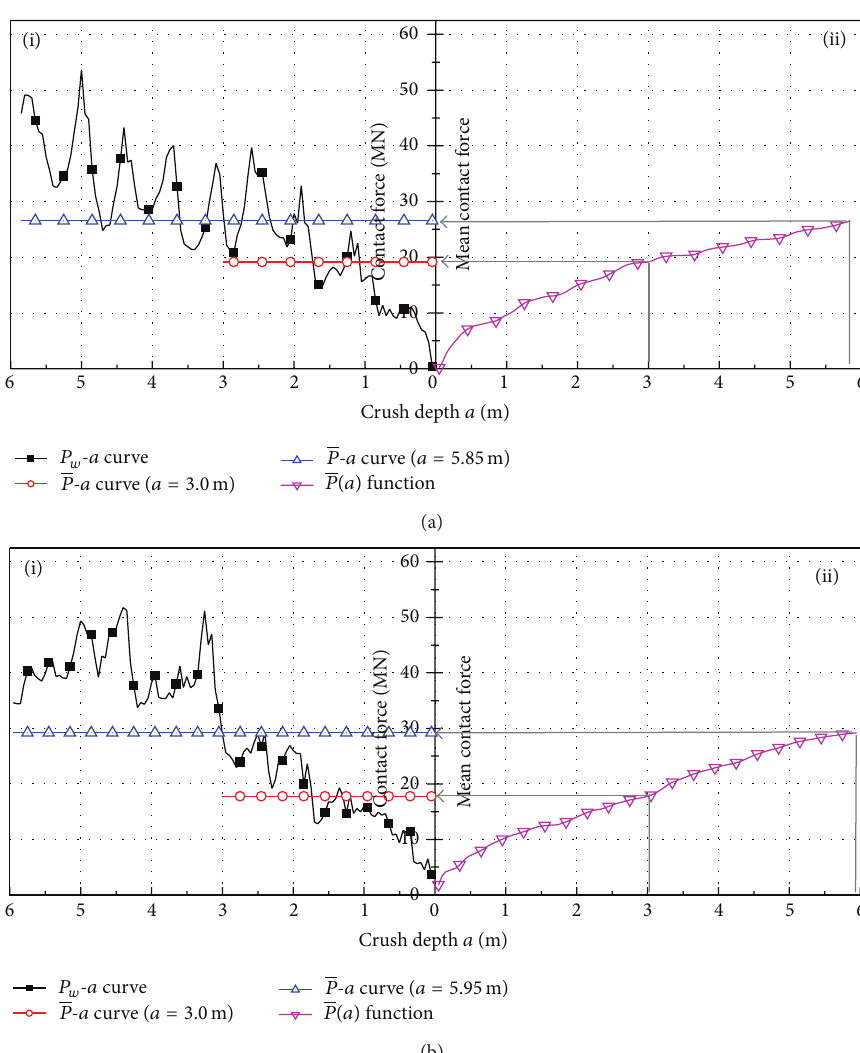
Figure 8: Mean contact force averaged over the damage depth: (a) 5,000 DWT; (b) 10,000